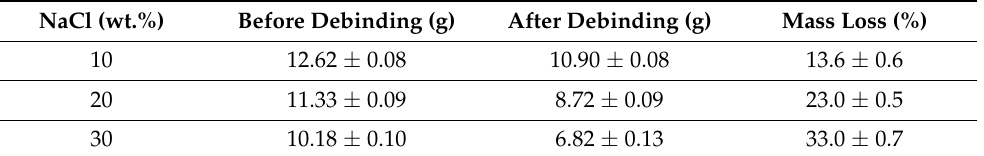
Table 2. Porous 440C sample masses before and after